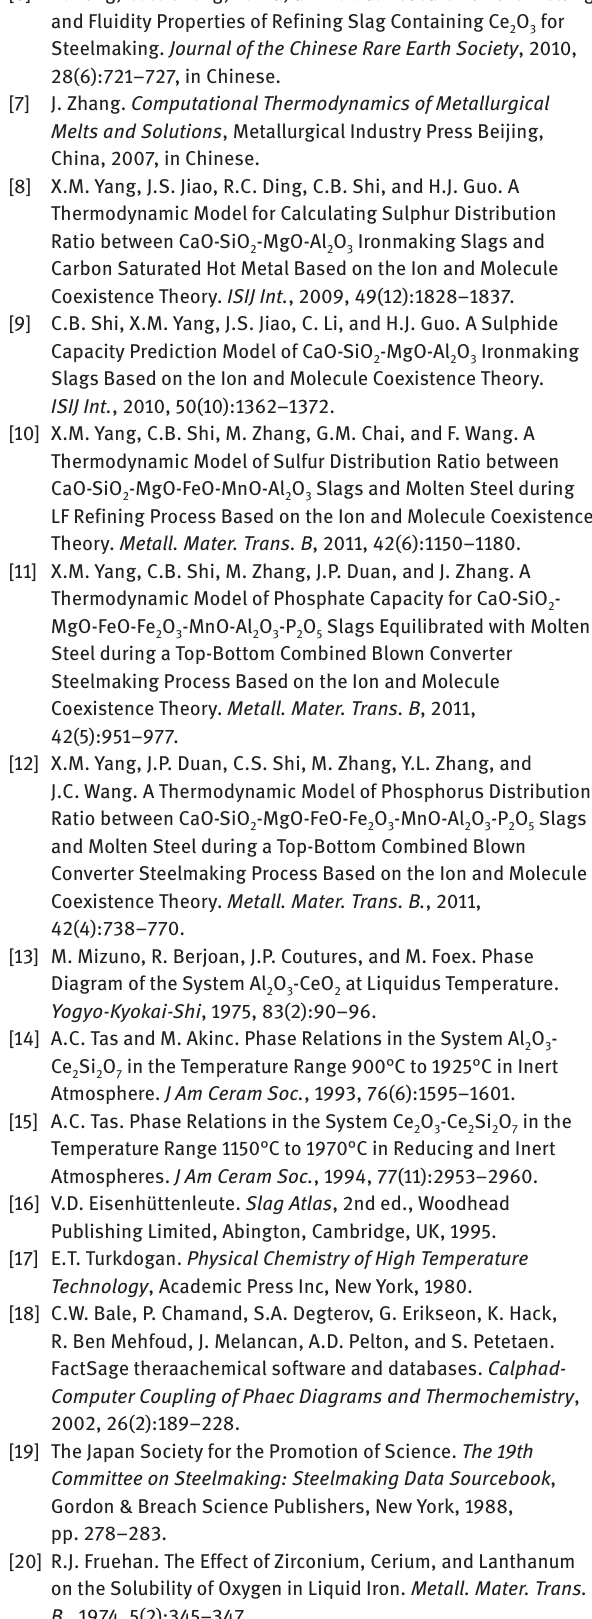
mass action concentrations of each structural unit were gained in the three slag systems. 2. In Ce O -Al O slag system, results show that when 2 3 2 3 mole fraction of Ce O is 0.49, the mass action 2 3 ⋅ Al concentration of Ce O O achieves its maximum 2 3 2 3 value 0.90 and both the mass action concentrations of Ce O and Al O maintain at very low values. 2 3 2 3 However, if mole fraction of Ce O is greater than 2 3 0.49 the mass action concentration of Ce O would 2 3 increases sharply. Oppositely, when mole fraction of Ce O is smaller than 0.49 the mass action 2 3 concentration of Al O would increases rapidly. 2 3 3. In CaO-Al O -Ce O slag system, the trends of 2 3 2 3 calculated mass action concentration of Al O are 2 3 in good agreement with the reported measured trends of activity of Al O , namely, the mass action 2 3 concentration of Al O decreases with the increasing 2 3 of CaO/Al O at a certain content of Ce O and with 2 3 2 3 the increasing of Ce O content at a certain value of 2 3 CaO/Al O . The iso-mass action concentration curves 2 3 of Ce O and CaO are drawn from the calculated 2 3 results. 4. On the basis of previous work, a thermodynamic model formulation of the equilibrium between CaO-Al O -SiO -Ce O slag and molten steel 2 3 2 2 3 containing aluminum has been discussed. Results show that certain content of cerium would be dissolved in molten steel equilibrated with which increases with the increasing of temperature and aluminum content, and the corresponding cerium content is in the range of 1.87 ∼ 13.30 ppm when the aluminum content is 0.02% at 1873